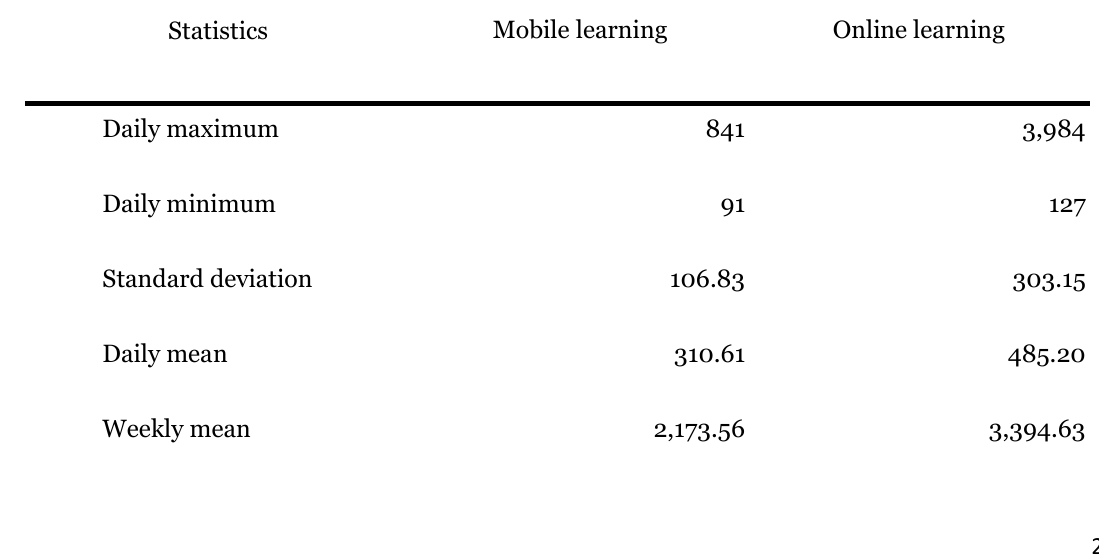
Descriptive Statistics of the Tweets Related to Mobile and Online